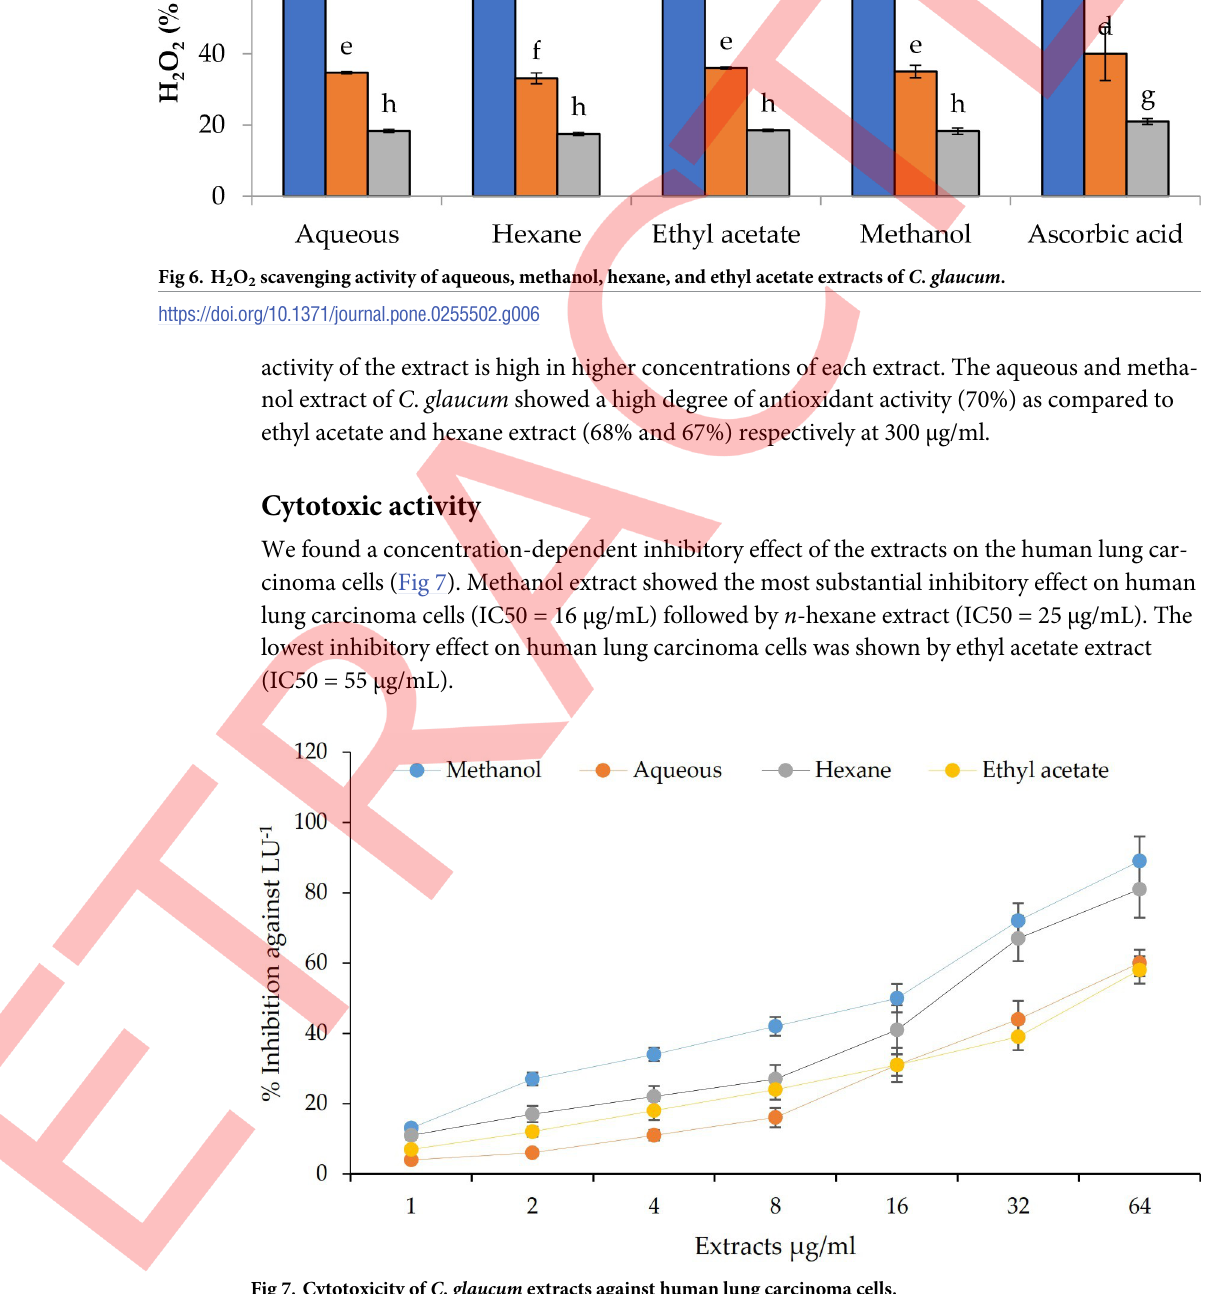
Fig 7. Cytotoxicity of C . glaucum extracts against human lung carcinoma cells.